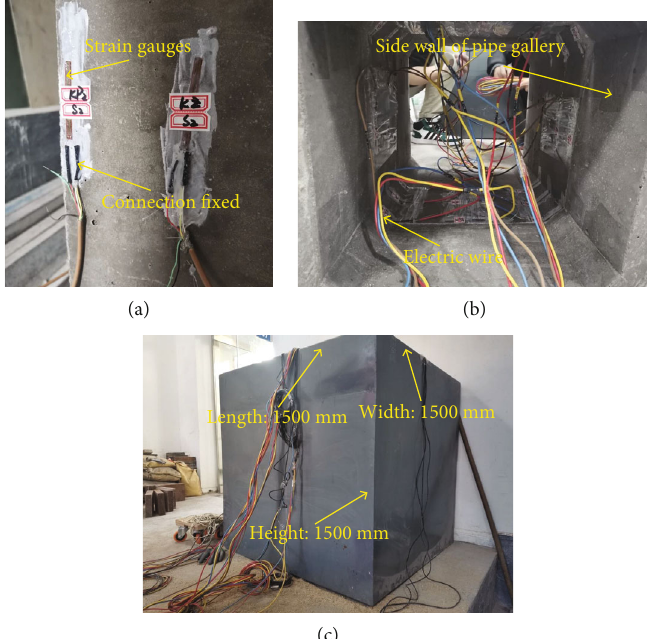
Figure 6: Laboratory apparatus. (a) Strain gauge. (b) Outer lead of the tube section. (c) Physical drawing of experimental model